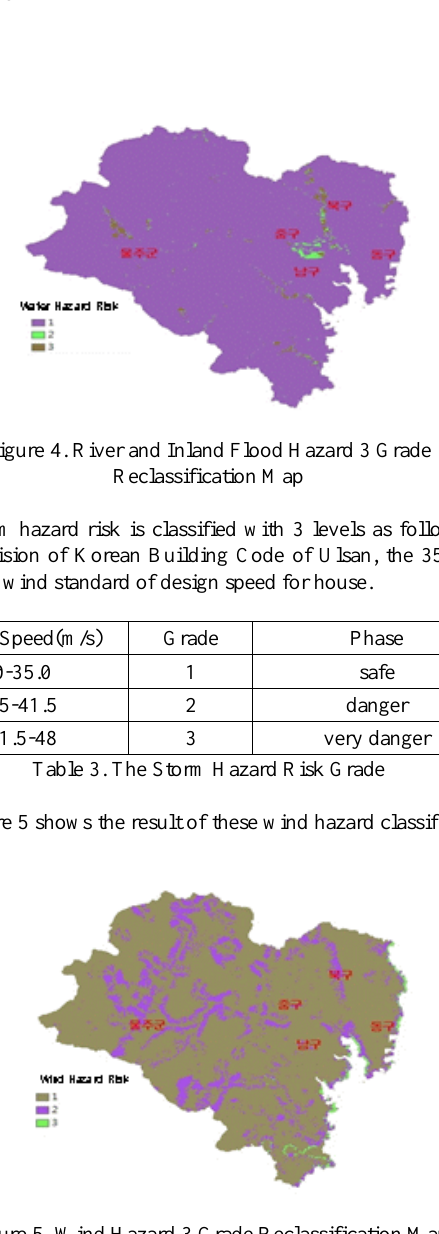
Figure 5. Wind Hazard 3 Grade Reclassification Map